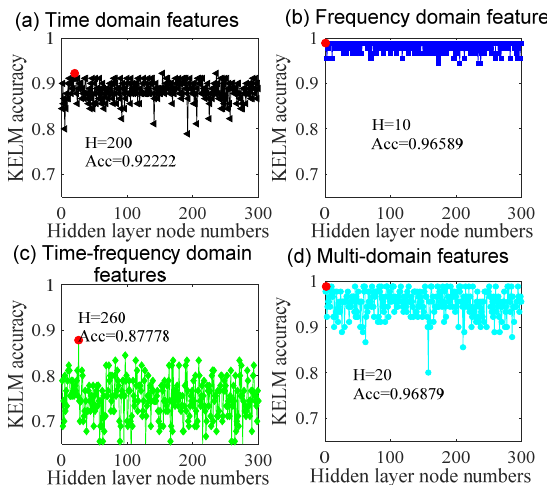
Figure 15. Diagnosis results for check valve with the time − domain, frequency − domain, time–fre- quency − domain, and multi − domain features using different numbers of hidden layers in KELM. Table 10. Corresponding results for node numbers different numbers of hidden layers. Table 10. Corresponding results for node numbers different numbers of hidden